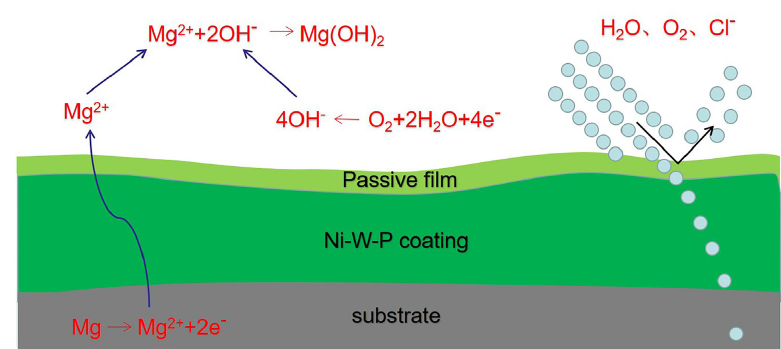
Figure 7. Anti-corrosion mechanism for Ni-W-P coating.